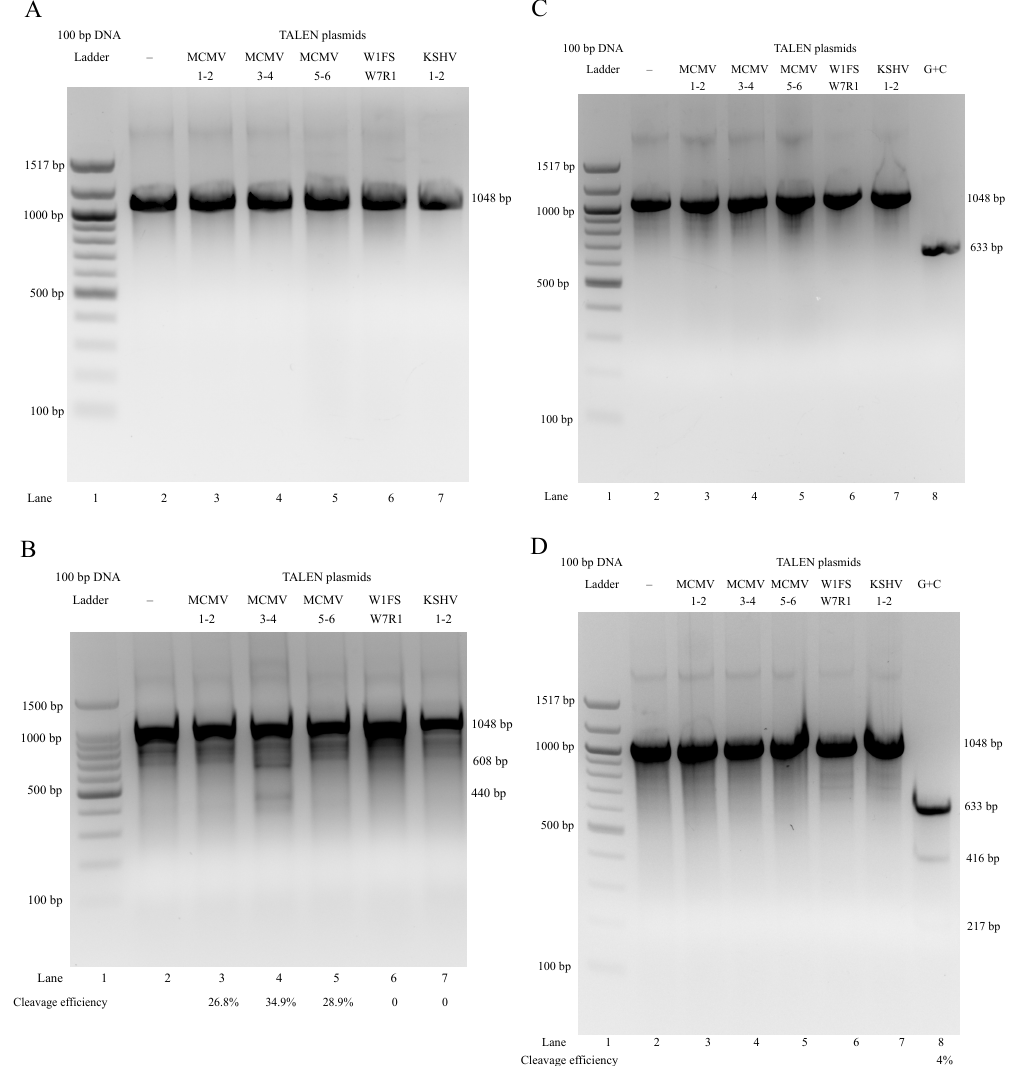
Figure 7. TALEN plasmid transfection was prior to MCMV infection: ( A ) Only homoduplex (or heteroduplex) PCR products (1048 bp) were observed (Lane 2–7). ( B ) Only MCMV3-4 (Lane 4) target and cleave PCR products produced two extra DNA bands (608 and 440 bp) clearly. MCMV1-2 and 5-6 (Lane 3 and 5) could not produce dominant extra bands, compared with the negative control (Lane 2). Neither the nonspecific TALEN plasmids W1FS-W7R1 (Lane 6) nor KSHV1-2 (Lane 7) could produce any extra bands, the same as the negative control (Lane 2). MCMV infection was prior to TALEN plasmid transfection: ( C ) Only homoduplex (or heteroduplex) PCR products (1048 bp) were observed (Lane 2-7). ( D ) No extra bands produced by TALEN plasmids were observed (Lane 3–7). Only positive control G + C (Lane 8) could produce dominant extra bands (416 and 217 bp) in addition to a major band (633 bp), compared with the negative control (Lane